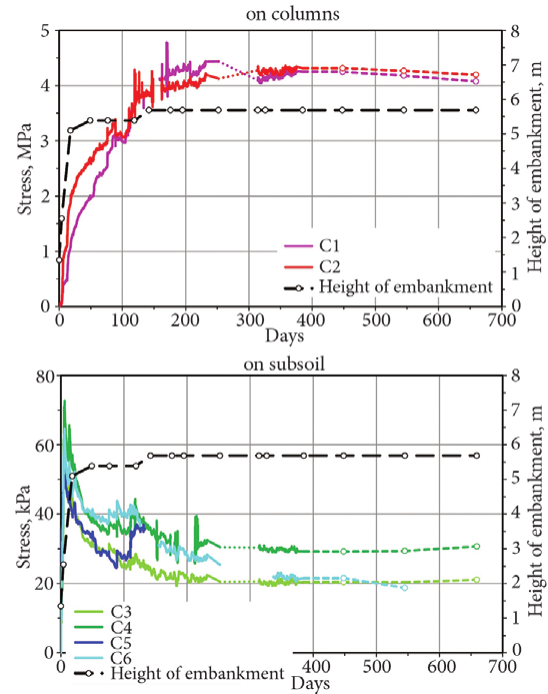
Fig. 11. Measured